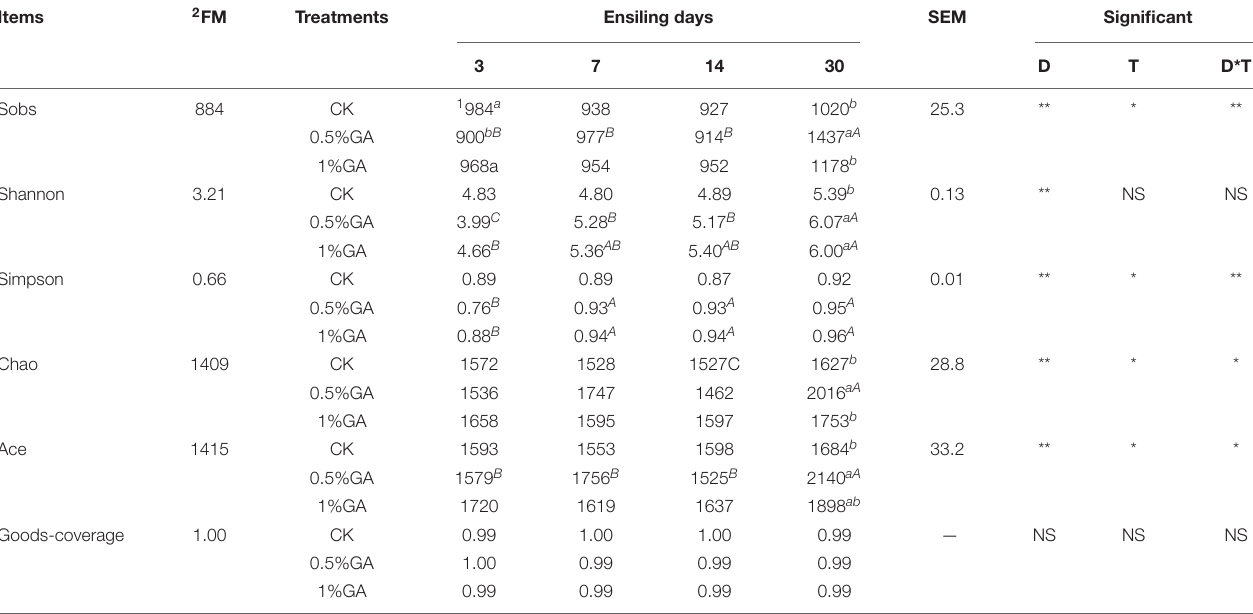
TABLE 4 | Alpha diversity of bacterial community of ensiled whole plant soybean.